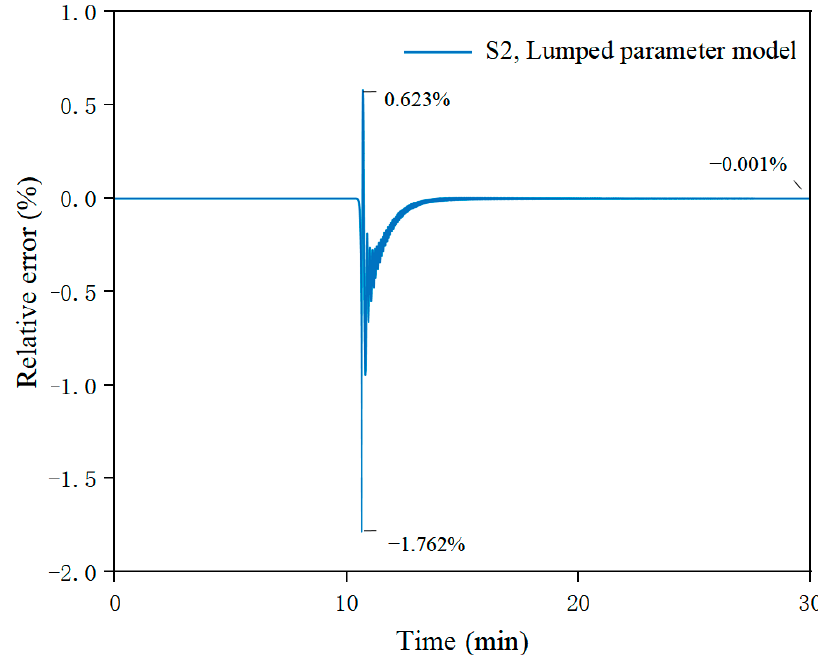
Figure 11. Calculation relative error of lumped parameter model.